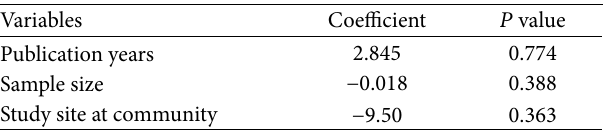
Figure 2: Subgroup prevalence of compliance to iron-folic acid supplementation Ethiopia, 2018 ( Table 2: Related factors with heterogeneity of compliance with iron-folic acid supplementation in the Current meta-analysis 2018 ). ( 𝑛 = 12